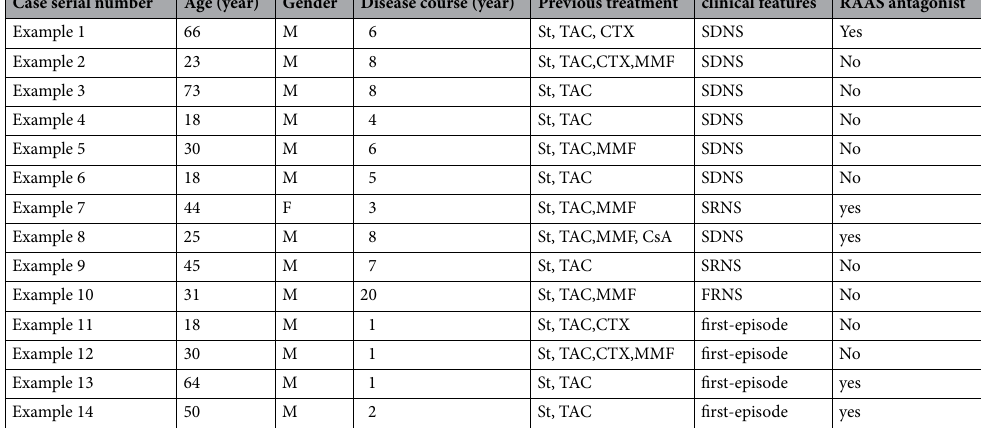
Table 1. Clinical data of the 14 patients with primary FSGS. St Glucocorticoid, TAC Tacrolimus, CsA Cyclosporine, MMF Mycophenolate ester, CTX Cyclophosphamide, SDNS Steroid-dependent nephrotic